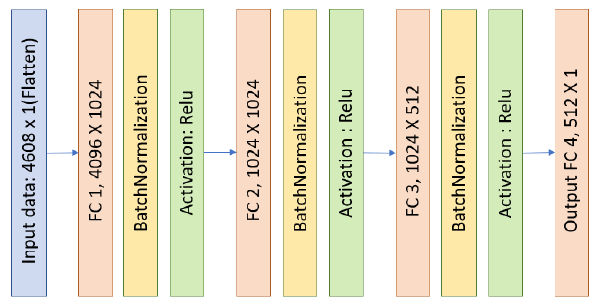
Figure 8. The architecture of the distance regression network.